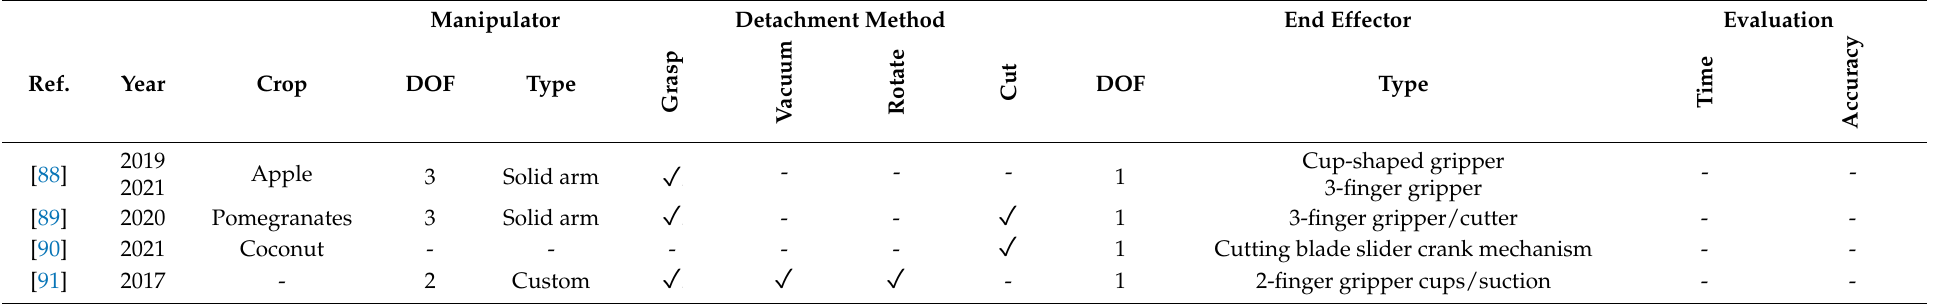
Table 1. Ground robotic manipulation systems for harvesting. Evaluation metrics of harvesting cycle time (time) and detachment success rate (accuracy) are included. Grasping from the stem is marked with “ ✓ s”; all other cases refer to direct contact grasping of the fruit.